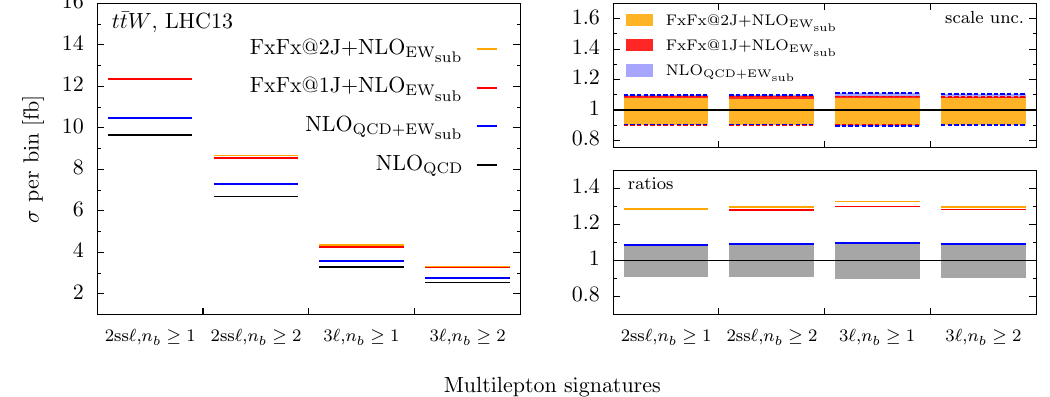
Figure 7 . Cross sections of various multi-lepton signal regions.